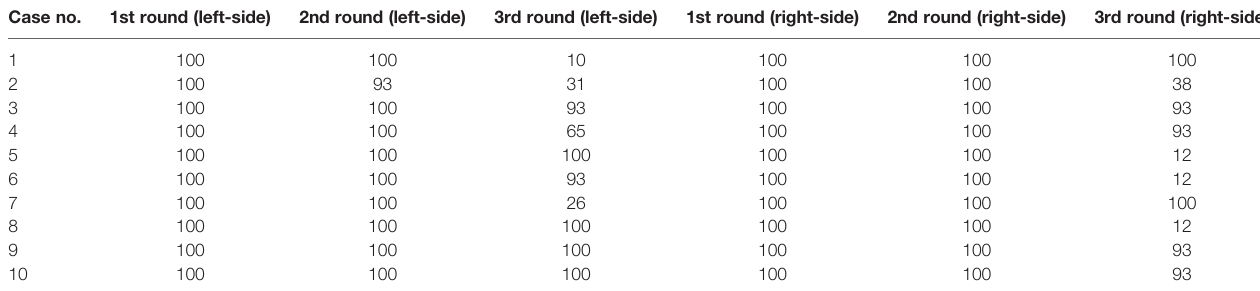
TABLE 10 | Iterations completed in each round of optimization of postmastectomy VMAT plans. Case